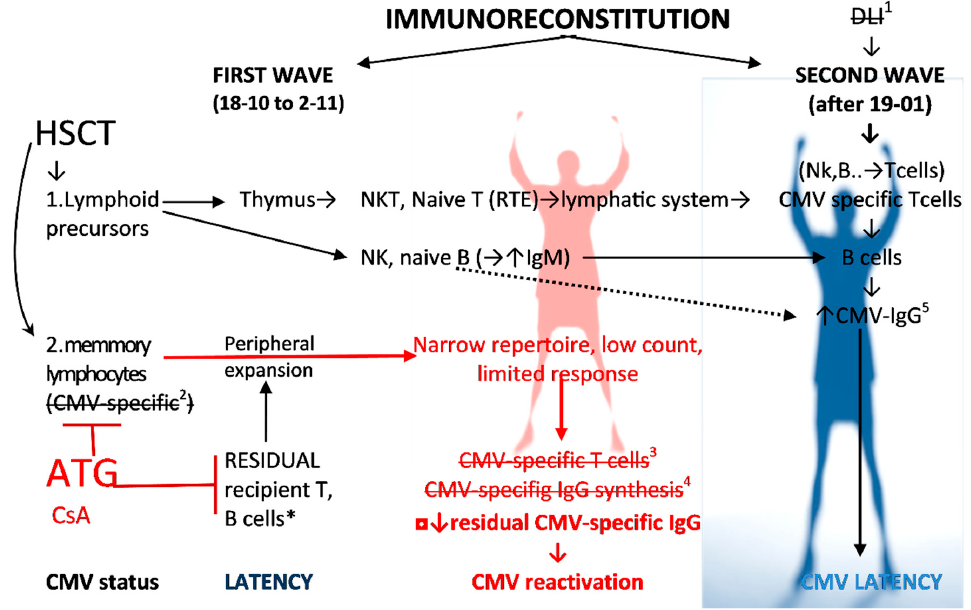
Figure 3. CMV specific reconstitution as a hallmark of adoptive immunorecovery after HSCT.